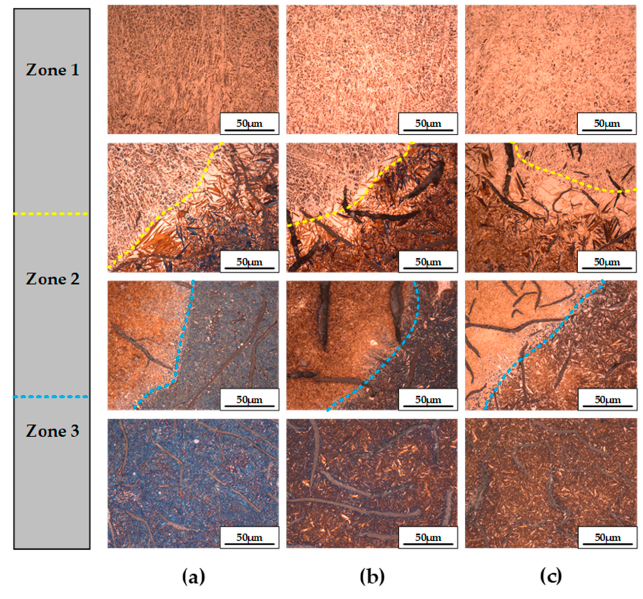
Figure 5. Microstructure of Difference Zones in the Matrix of Laser-Hardened Quench-Tempered Gray Cast Iron (LHQTGI) Specimens with Various Tempering Temperatures ( a ) 316 ° C; ( b ) 399 ° C; ( c ) 482 ° C. Table 6. Macro-Hardness of AGI and QTGI Specimens with Various Heat Treatment Designs.